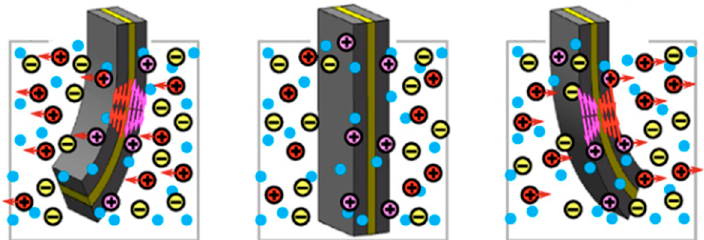
Figure 8. Bending of a trilayer actuator is caused by one CP film that swells by anion drive and the other CP film that shrinks by cation drive. Republished with permission of Royal Society of Chemistry, from Biomimetic polypyrrole based all three-in-one triple layer sensing actuators exchanging cations, García-Córdova et al., J. Mater. Chem., 21, 2011 [132]; permission conveyed through Copyright Clearance Center, Inc.